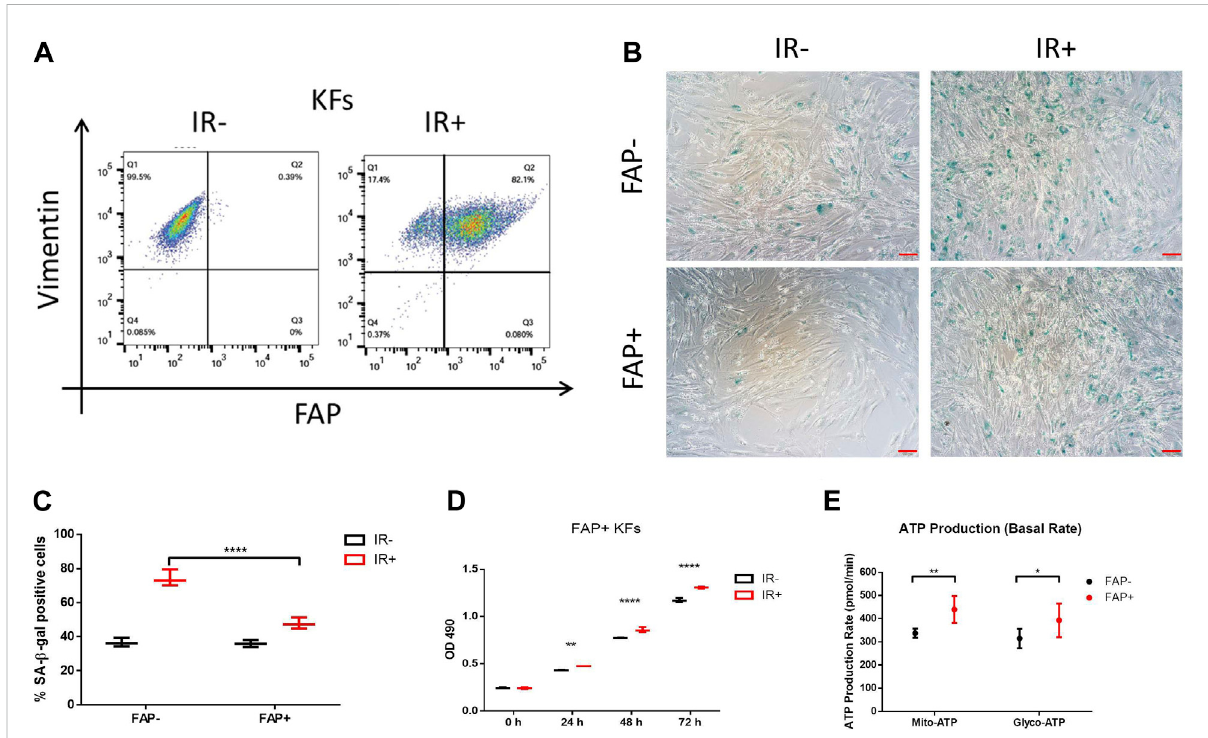
FIGURE 5 Irradiation(IR)promotedFAP+KFproliferationandinhibitedsenescence,accompaniedbyhighenergyproduction. Invitro ,primaryKFswithor withoutIRtreatmentwereanalyzedbyanti-hFAPandanti-hVimentinantibodystaining (A) .RepresentativeimagesofSA- β -galstaining (B) ;senescent cellsarestained green,scalebar=100 μ m.ThepercentageofsenescentcellsinFAP-versusFAP +KFsat72 hafter IR (C) .Dataarerepresentativeof three independent samples and are presented as the mean ± SD; n = 6; ****, p < 0.001. IR promoted FAP + KF proliferation (D) and increased intracellular ATP production (E) . Data from three experiments with essentiallythe same results werecombined and are presented as the mean ±